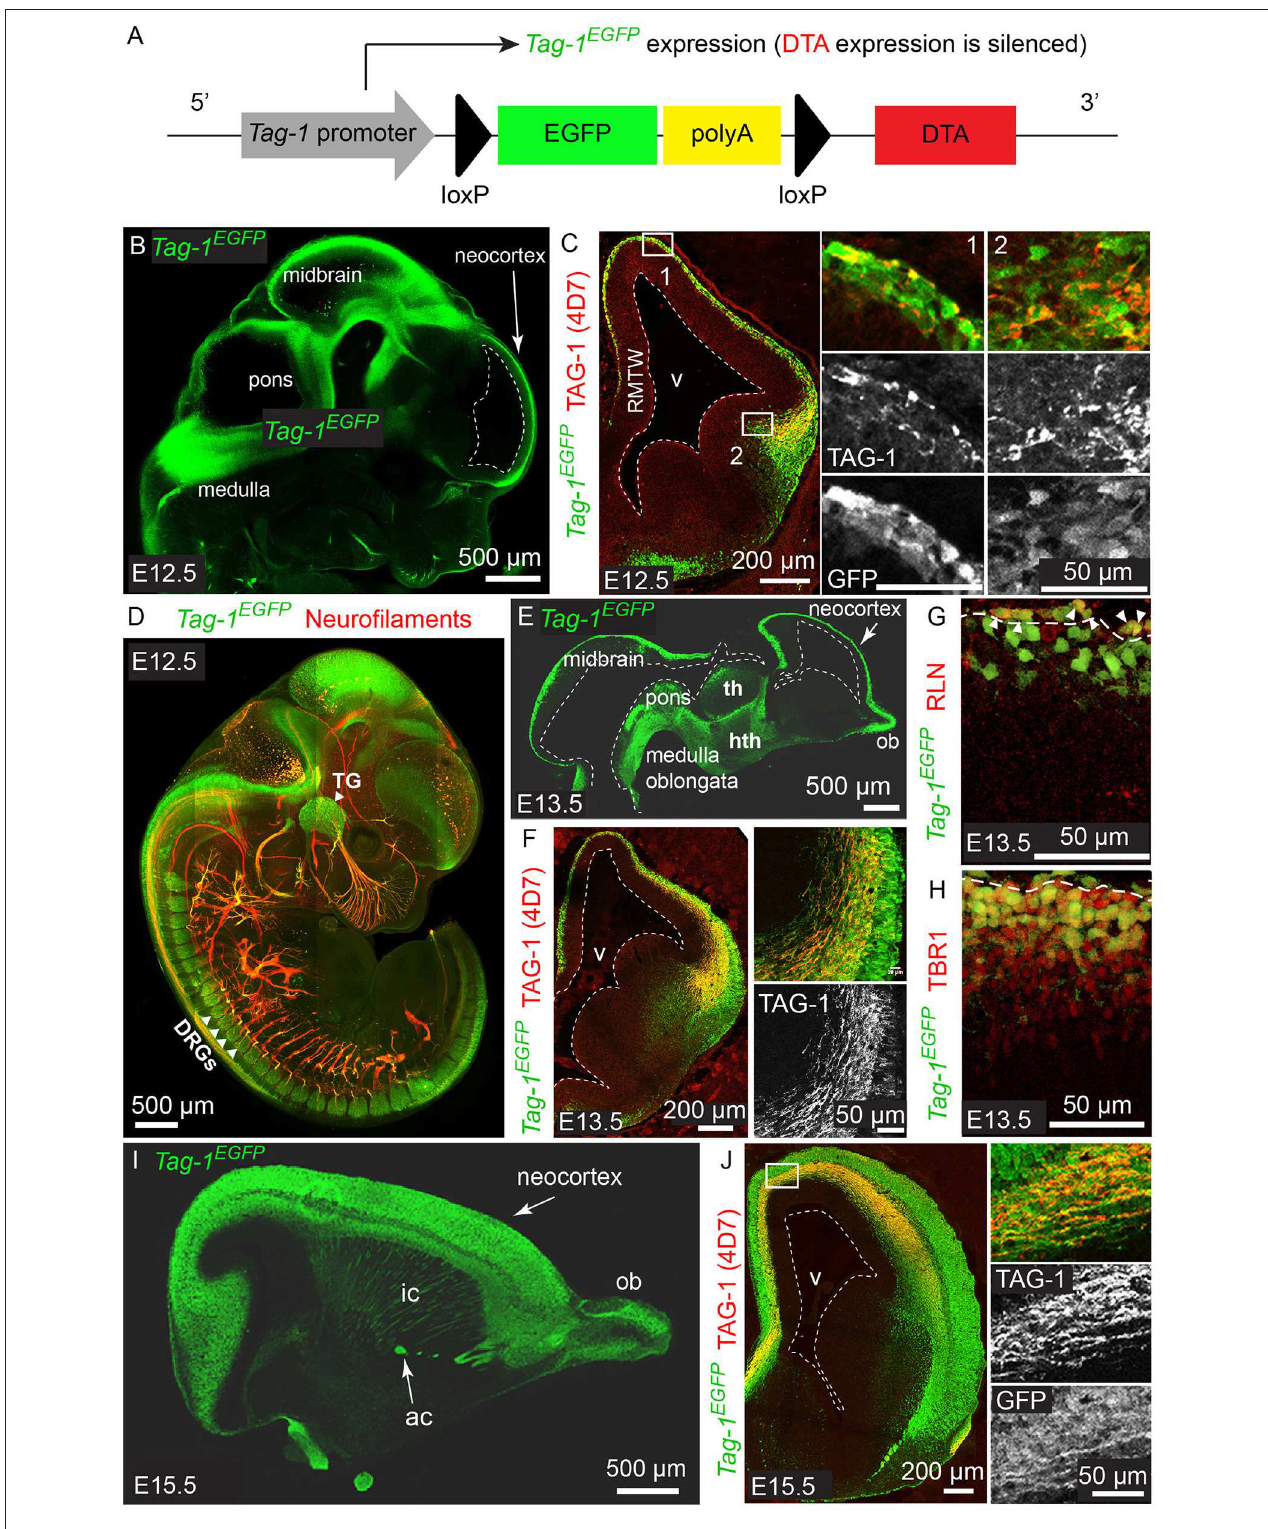
FIGURE 1 | Tag-1 EGFP is expressed in the developing cortex, thalamus, internal capsule and brainstem and colocalizes with endogenous TAG-1. (A) Overview of Tag-1 loxP − EGFP − loxP − DTA transgene structure, which drives Tag-1 EGFP expression without interfering with endogenous Tag-1 expression. (B,C)